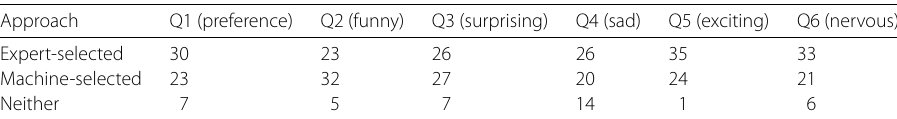
Table 7 Survey results( N =